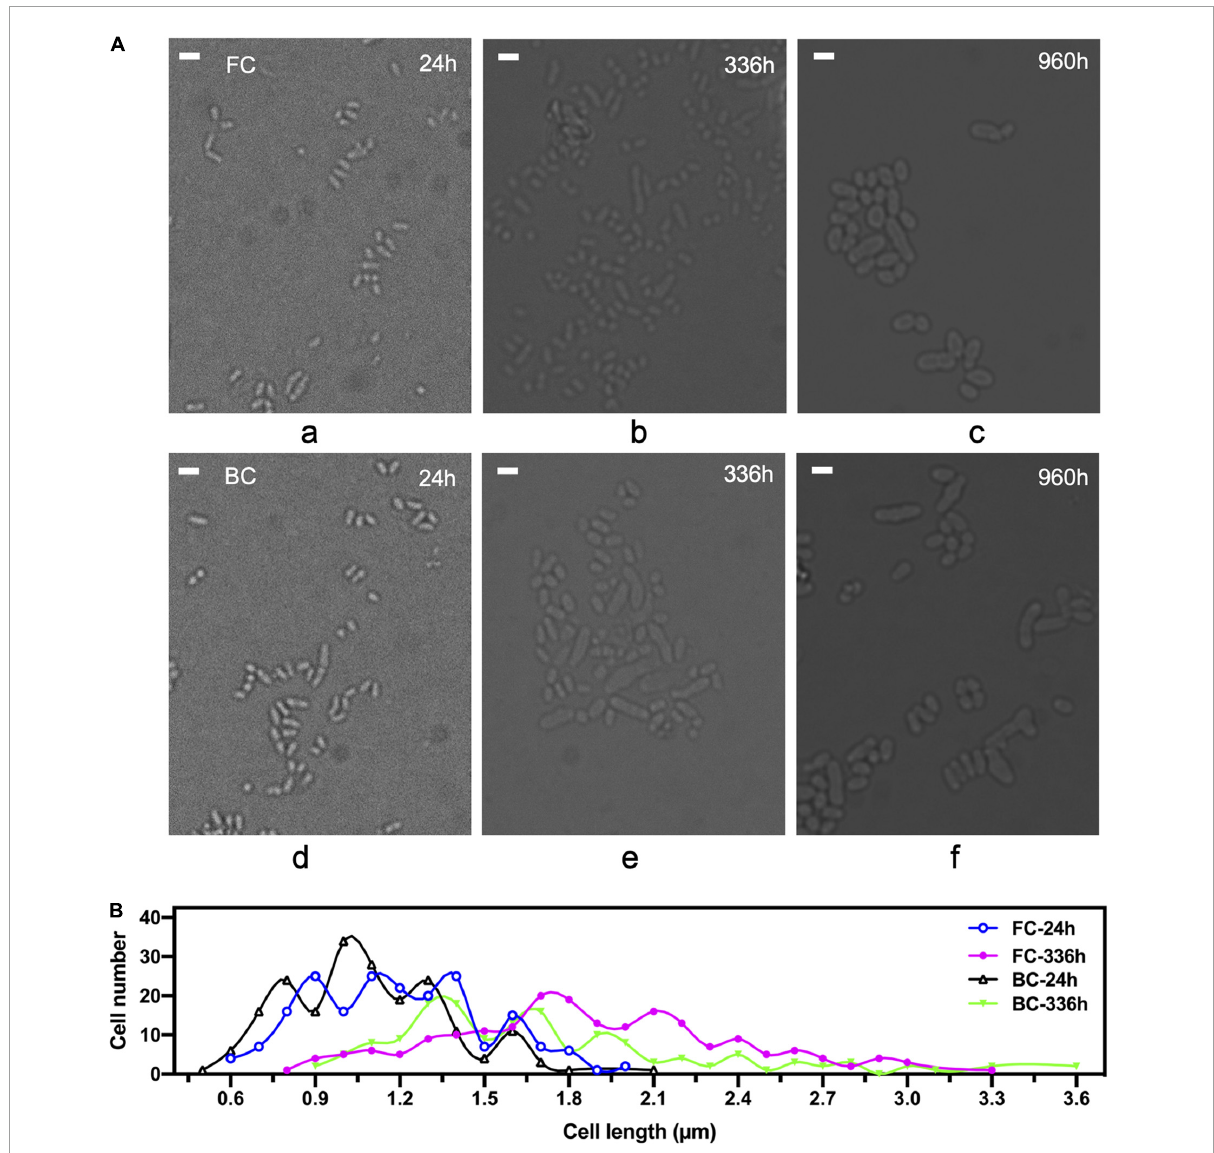
FIGURE2 Morphological changes of C. glutamicum cells over time during long-term repeated-batch fermentation. FC, free cells; BC, biofilm cells. (A) Observation of cells under a microscope. Scale bar, 2 µ m. (B) Statistical analysis of cell length under the microscope. 200 cells were counted and the cell length was measured by Image J software. The times indicate sampling time points at which cells of exponential growth phase during a repeated batch were